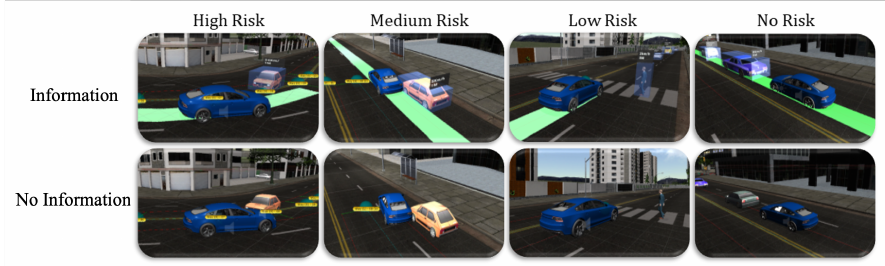
Figure 2. Eight scenarios categorized by level of risk and information provision on